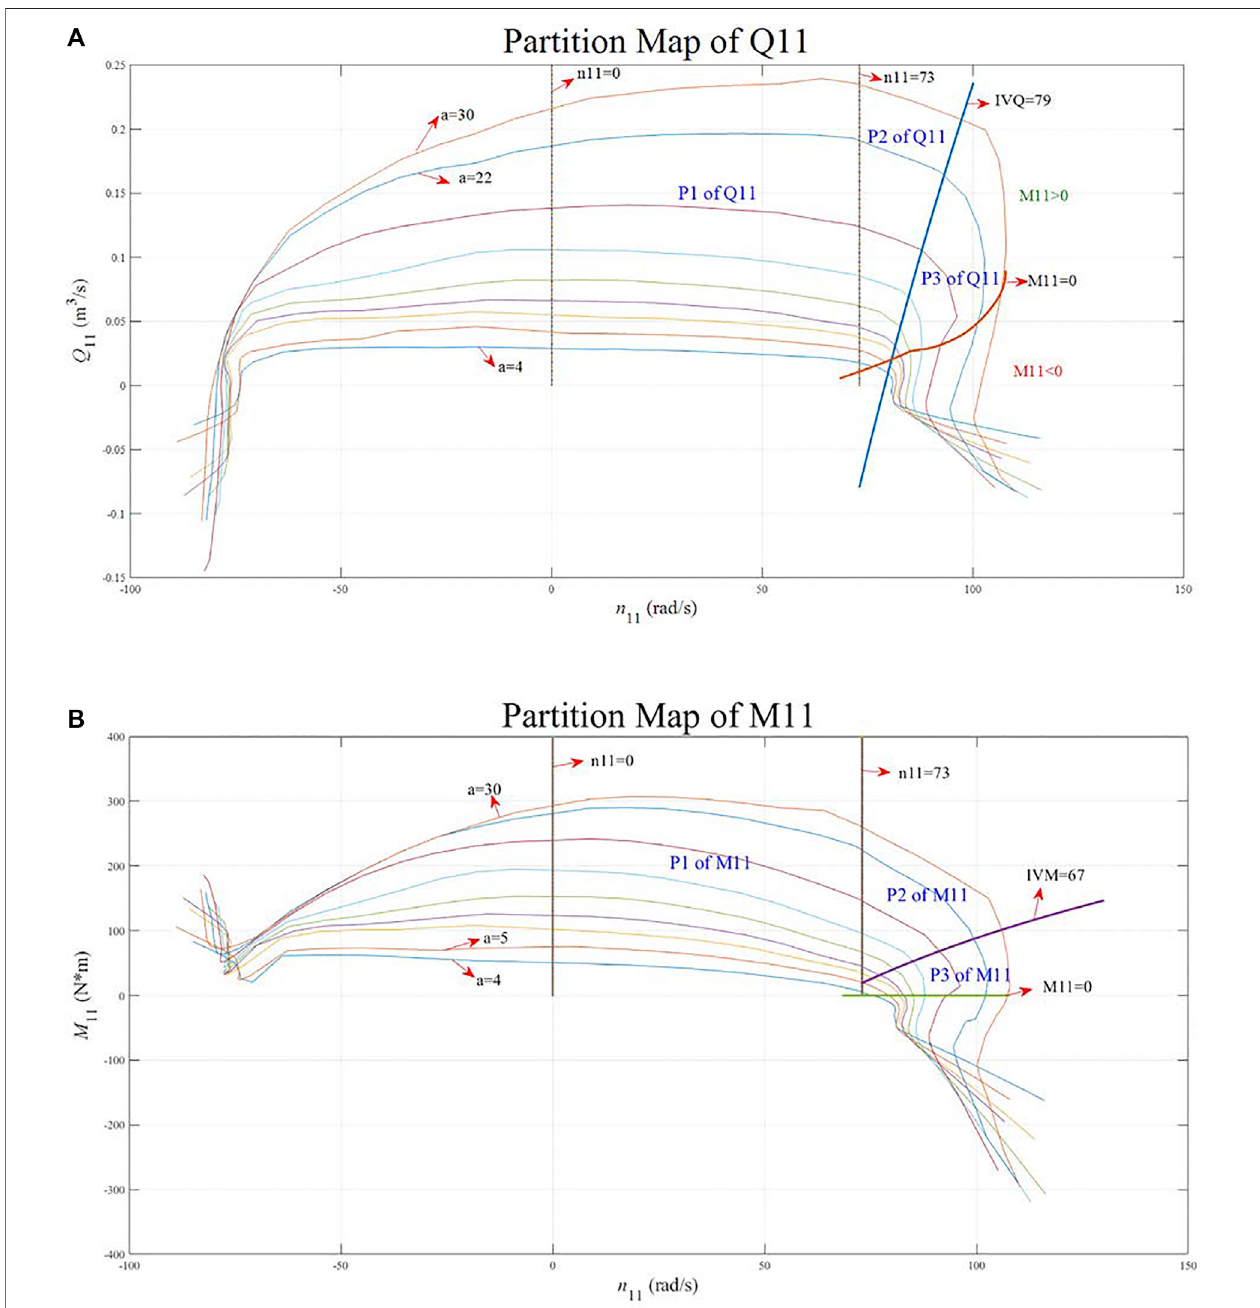
FIGURE 5 | Partition maps of (A) Q 11 and (B) M 11 .